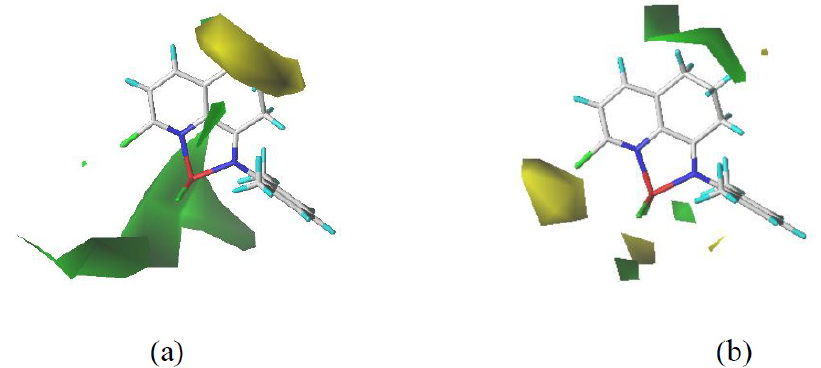
Figure 4. The 3D contour maps of the steric field for the model of ( a ) catalytic activity, and ( b ) molecular weight of product. The green and yellow regions indicate the positive and negative effects of the bulky group on catalytic performance, respectively.